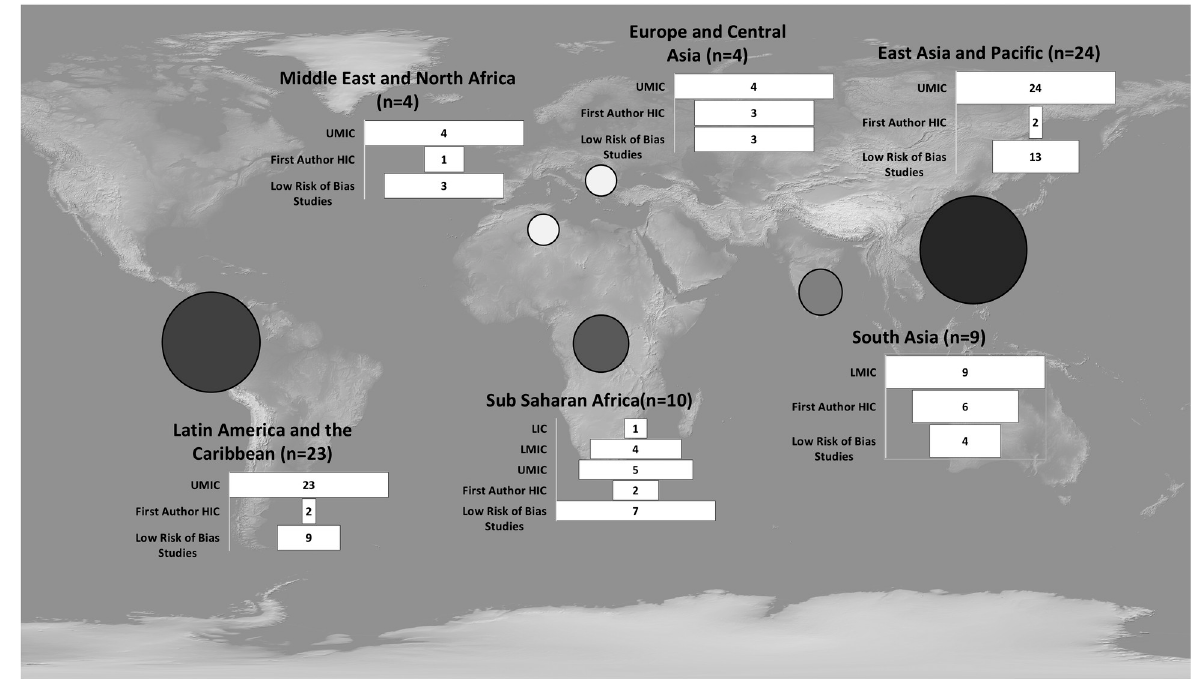
Fig 2. Study characteristics by location. SOURCE: Adapted from the public domain Natural Earth (https://www.naturalearthdata.com/ downloads/10m-raster-data/10m-gray-earth/). NOTE: HIC = high income country, UMIC = upper middle income country, LMIC = lower middle income country, LIC = low income